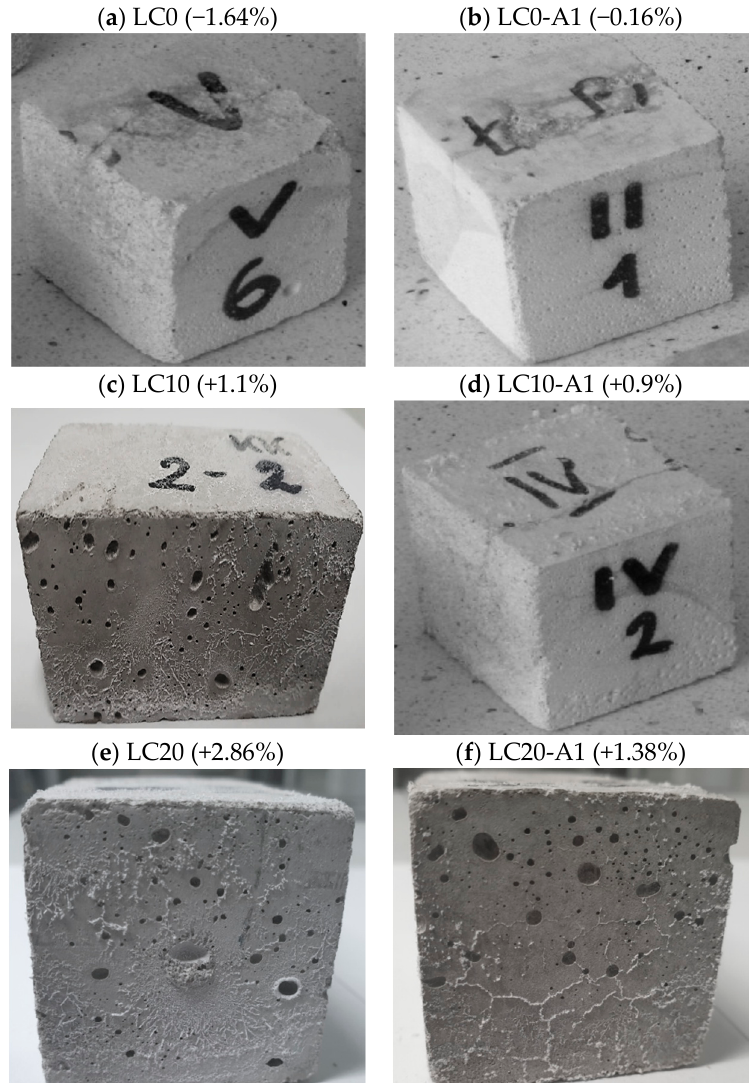
Figure 6. Samples after salt crystallization test. ( a ) LC0 ( − 1.64%); ( b ) LC0-A1 ( − 0.16%); ( c ) LC10 (+1.1%); ( d ) LC10-A1 (+0.9%); ( e ) LC20 (+2.86%); ( f ) LC20-A1 (+1.38%).